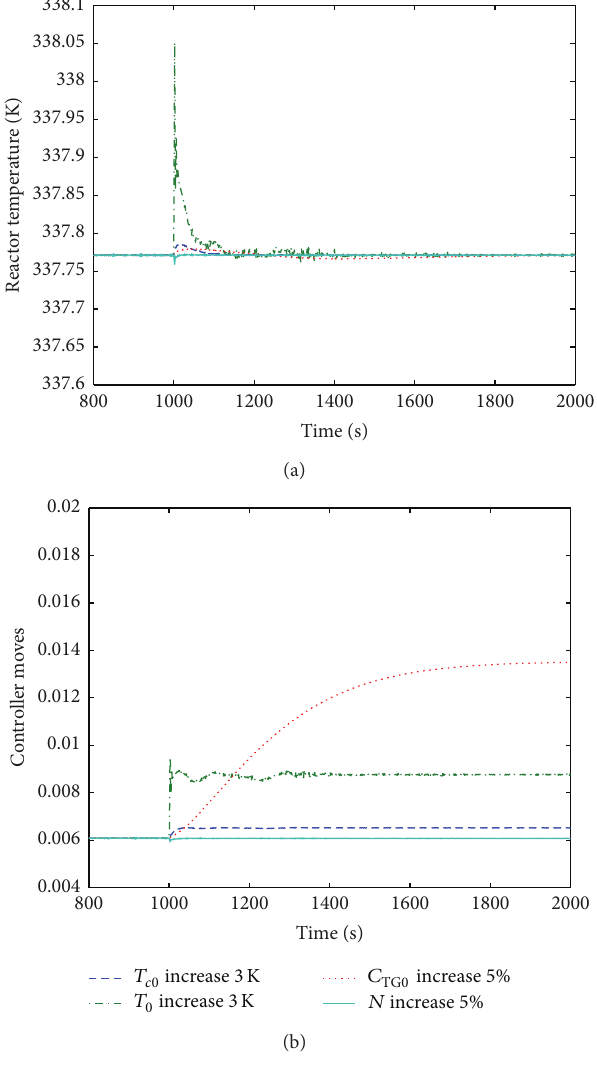
Figure 13: Reactor temperature and controller moves of four individual disturbance variables